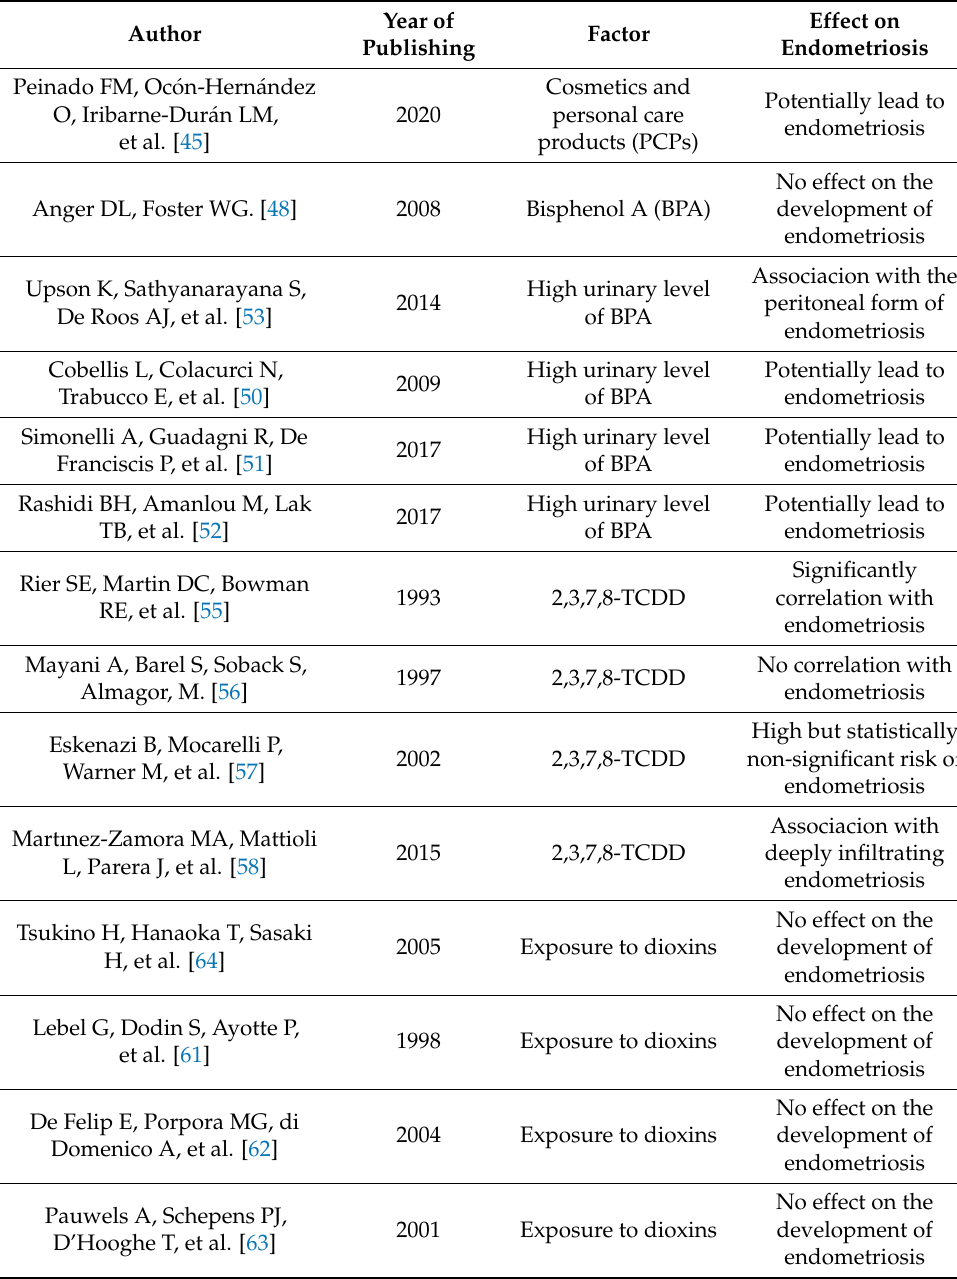
Table 3. EDC factors of